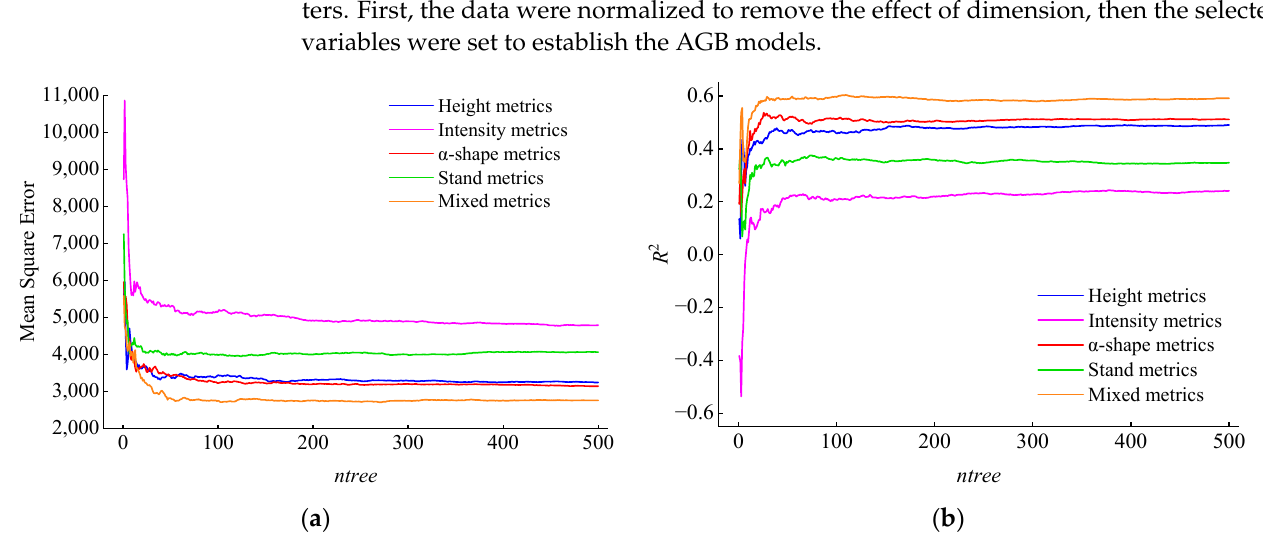
( e ) Figure 4. Features correlation of each group features: ( a ) Height metrics; ( b ) Intensity metrics; ( c ) Alpha- shape metrics; ( d ) Stand metrics; ( e ) Mixed metrics.